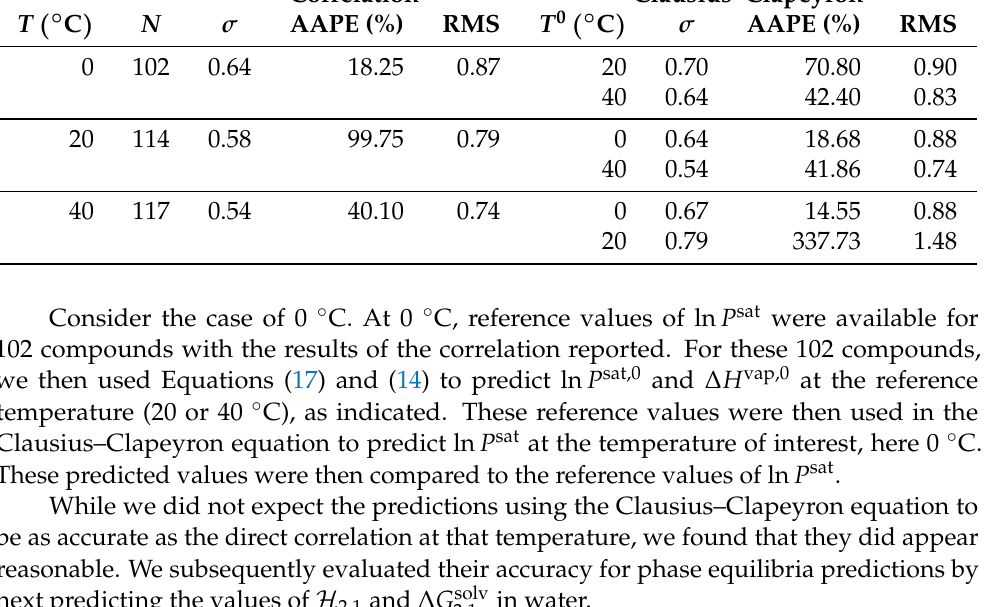
Table 4. Summary of the error in the predicted log Henry’s constant (ln H 2,1 , Equation (3)) for organic solutes in water, where H 2,1 is in units of bar. The error is quantified using the standard deviation computed for the difference between the calculated and reference value ( σ ) and the root- mean-squared error (RMS), the average absolute percent error (AAPE), the average absolute error (AAE), and R 2 , where N is the number of organic solutes for which reference data were available. The majority of the data were at 25 ◦ C. Predictions were made for MOSCED with ln P sat using the Clausius–Clapeyron equation with a reference temperature of 20 and 40 ◦ C, as indicated, plus the use of the reference vapor pressure for comparison. Predictions were additionally made using mod-UNIFAC with the reference vapor